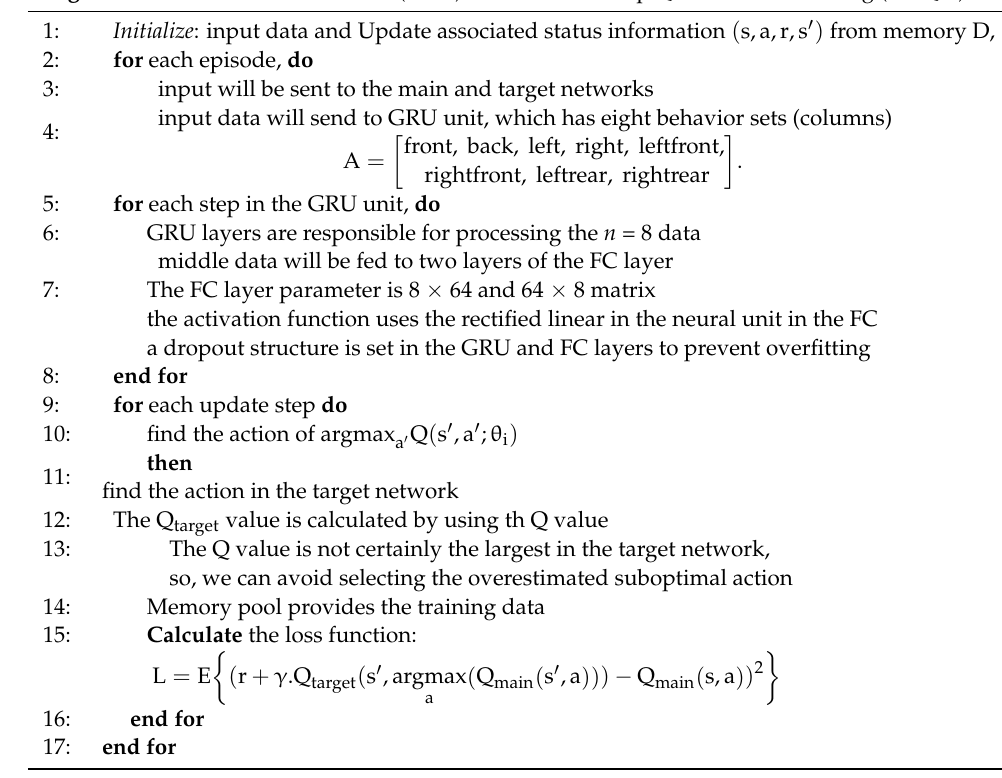
Algorithm 2. Gated Recurrent Unit (GRU) with Double Deep Q-Networks Learning